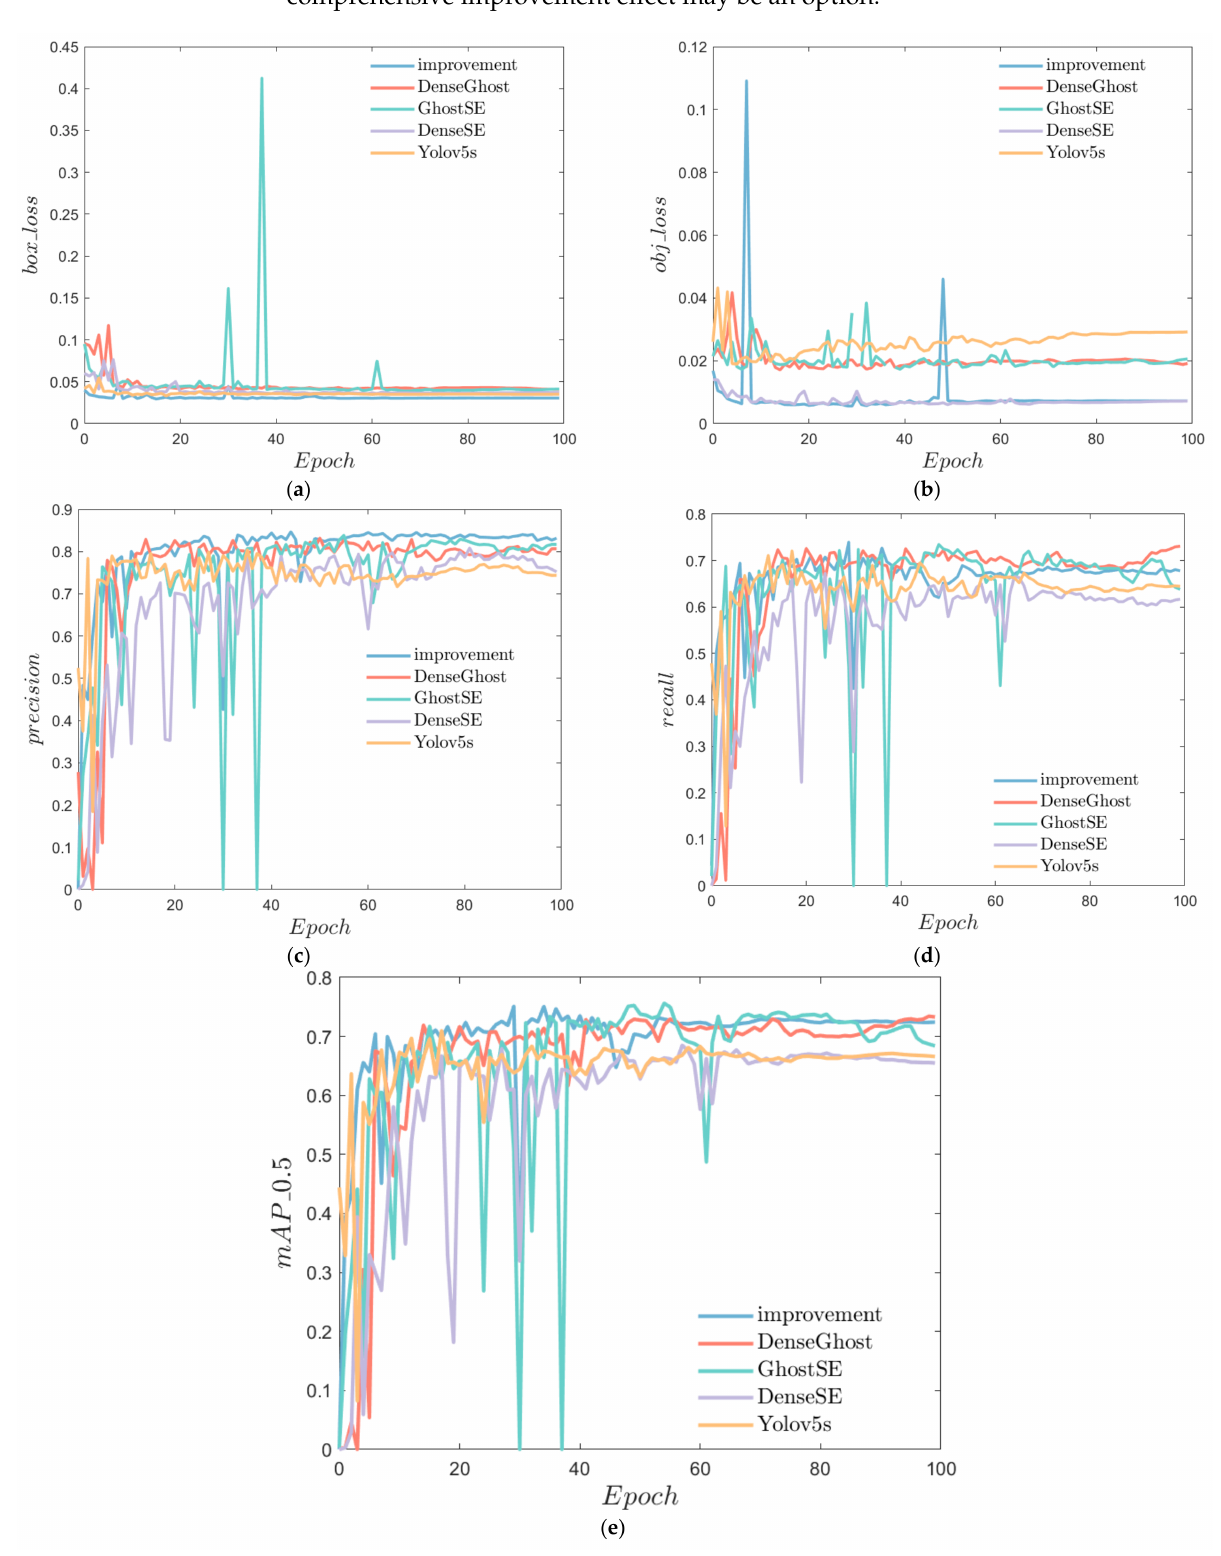
Figure 20. Comprehensive improvement comparison chart. ( a ) Target loss. ( b ) Anchor-frame loss; ( c ) Accuracy rate. ( d ) Recalling rate. ( e ) mAP